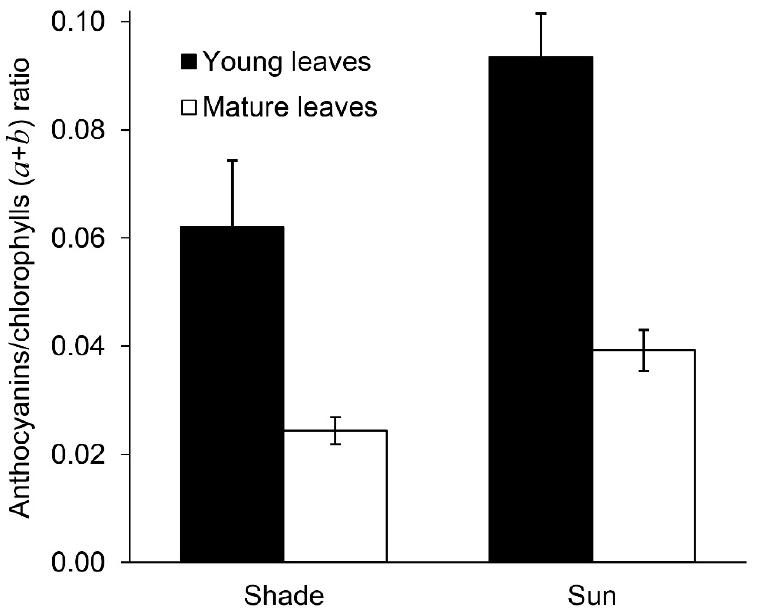
Figure 6. Anthocyanins/chlorophylls ( a + b ) ratio in young and mature leaves of Hydrocharis morsus- ranae in the different